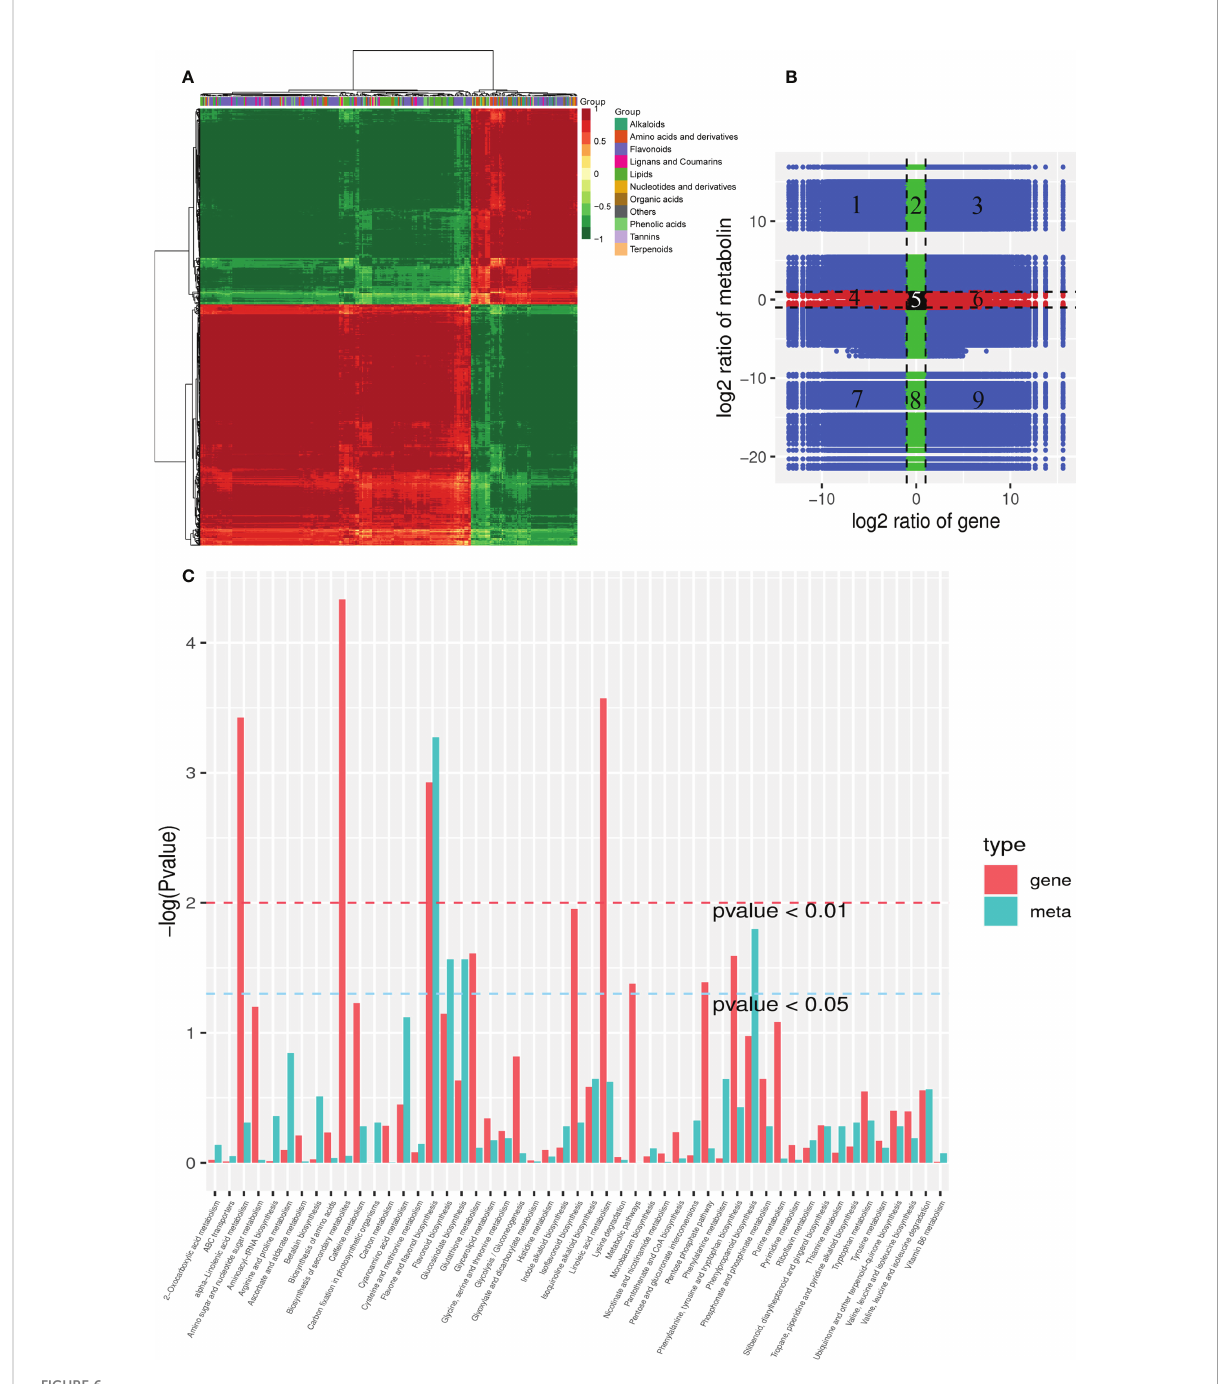
FIGURE 6 Combined analysis of the transcriptome and metabolome. (A) Cluster analysis of the correlation coef fi cients between the DEGs and DAMs. (B) DEG and DAM foldchanges in a nine-quadrant plot. The x-axis represents the log 2 FC of the DEGs, where FC is the foldchange in gene expression; that is, the ratio of the FPKM of OEGA/FPKM of CON. The y-axis represents the log 2 FC of DAMs, where FC is the foldchange in the metabolite content between the OEGA and CON groups. Black dots represent unchanged genes or metabolites, green dots represent DAMs vs. unchanged gene expression, red dots represent DEGs vs. unchanged metabolites, and blue dots represent changes in gene expression and metabolites. The black dashed lines represent the thresholds for log 2 FC = 1 and divide the graph into nine quadrants. The metabolites and genes in the third and seventh quadrants showed consistent changes. (C) Joint KEGG enrichment P value histogram of the DEGs and DAMs in the CON and OEGA. The smaller the P value, the higher the degree of